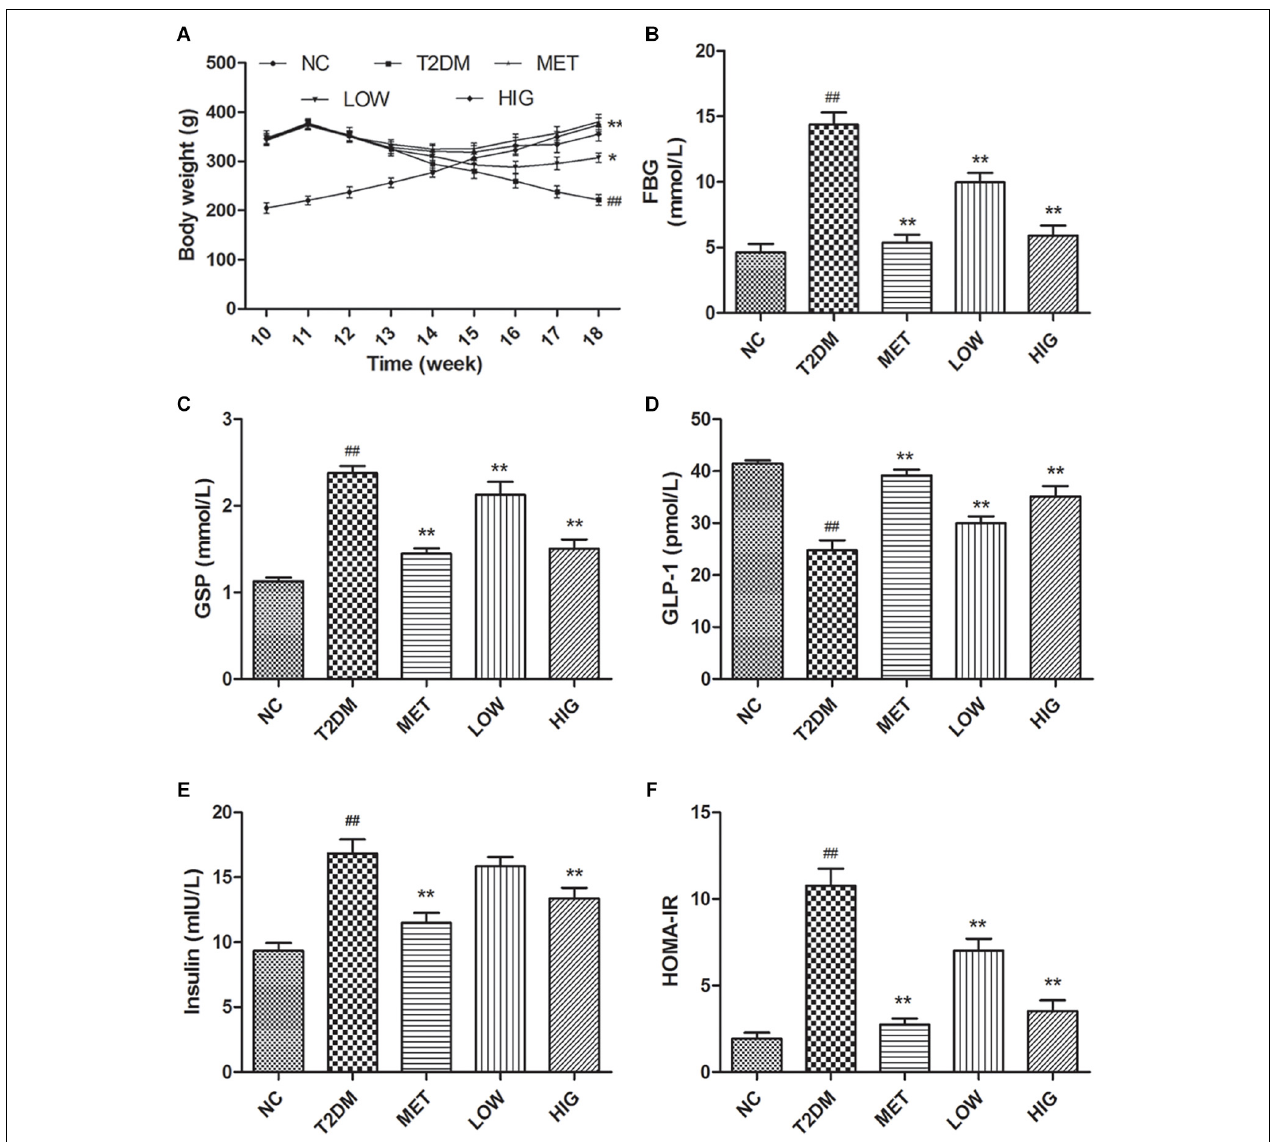
FIGURE 2 | Effect of RAGP on body mass and serum biochemistry in each group ( n = 6). (A) Body weight of all rats from 10 to 18 weeks. At 12th week, T2DM rats were injected with STZ (i.p.). (B) Serum FBG, (C) GSP, (D) serum GLP-1, (E) fasting serum insulin, and (F) HOMA-IR were tested at the end of the 18 weeks. Values are mean ± SD, # P < 0.05, ## P < 0.01 vs. NC group; ∗ P < 0.05, ∗∗ P < 0.01 vs. T2DM